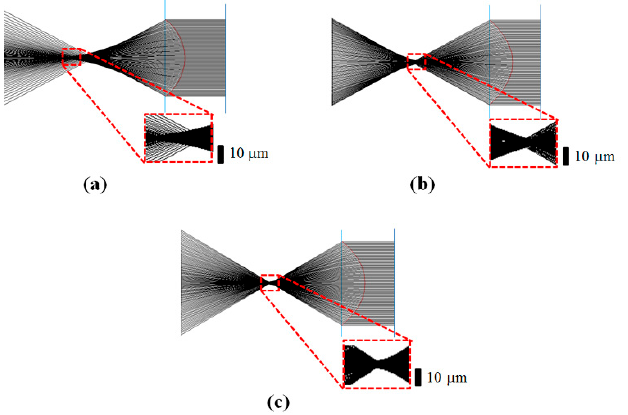
Figure 4. ( a ) Positional curvature profiles and ( b ) positional curvature slopes for the low- ∆ n LC GRIN lens arrays with spherical, quadratic polynomial aspherical, and high-order (fourth-order) polynomial aspherical curvatures.